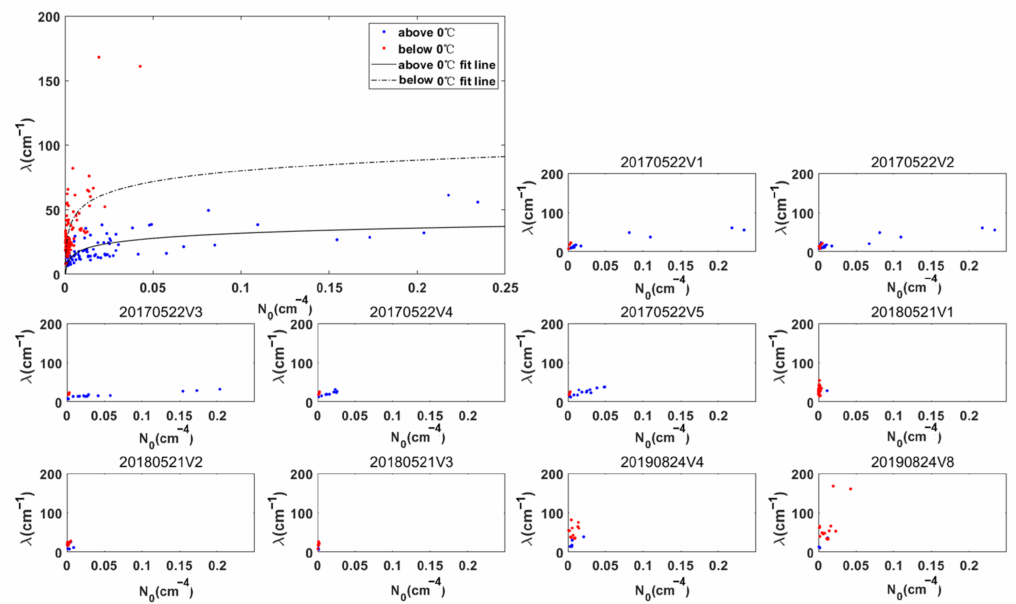
Figure 19. The relationship of λ and D max